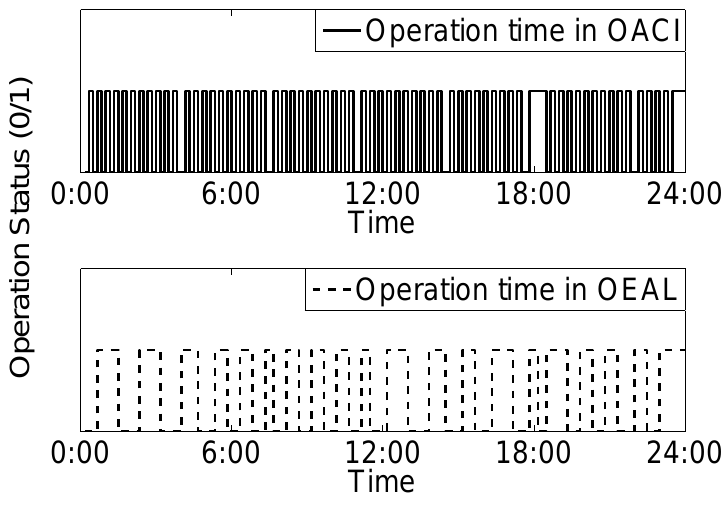
Figure 6. Comparison of the operation time for EWH.